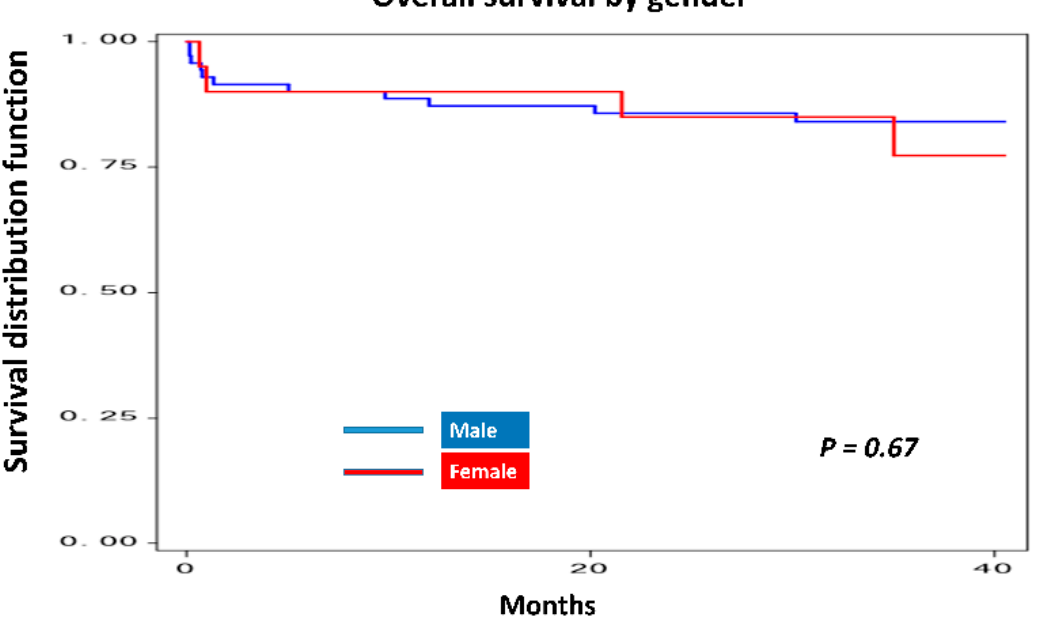
Figure 3. Kaplan–Meier plot of overall survival by gender. Kaplan–Meier survival curves for the preoperative and one-year postoperative NRI are shown in Figure 4. The NRI was classified into two groups: moderate-to-severe nutritional risk (NRI < 97.5) and mild-to-absent nutrition risk (NRI ≥ 97.5). Participants with moderate-to-severe nutrition risk had a lower survival by 81.40% (the mean survival time = 30.97 months) compared to the participants with mild-to-absent nutrition risk, who had a survival of 85.11% (the mean survival time = 10.84 months). However, interestingly, one year postoperative NRI showed significantly that mild-to-no nutritional risk patients had a higher percentage of living by 97.10% (the mean survival time = 29.77 months), compared to moderate-to-severe nutritional risk patients with 50.80% percentage of survival (the mean survival time = 16.5 months), ( p <